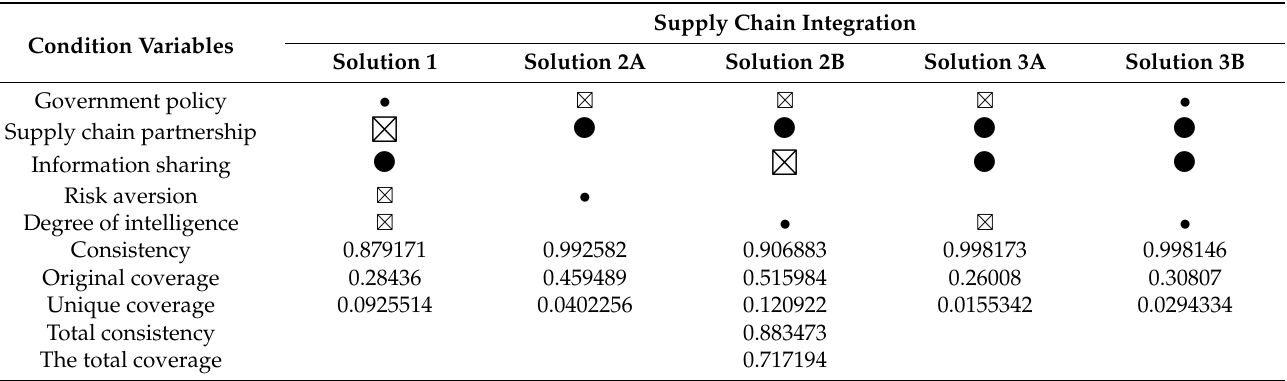
Table 6. Configuration of supply chain integration